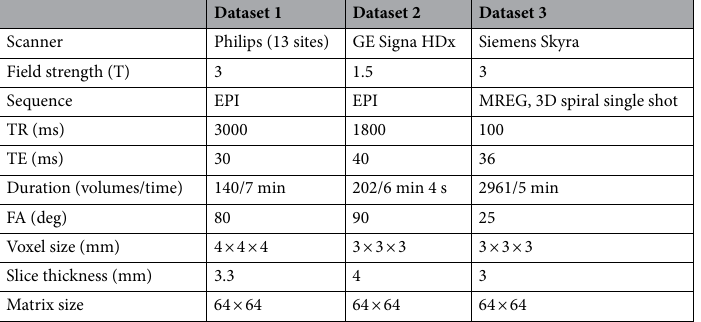
Table 1. Imaging parameters for functional data . TR = Repetition time. TE = Echo time. FA = Flip angle.